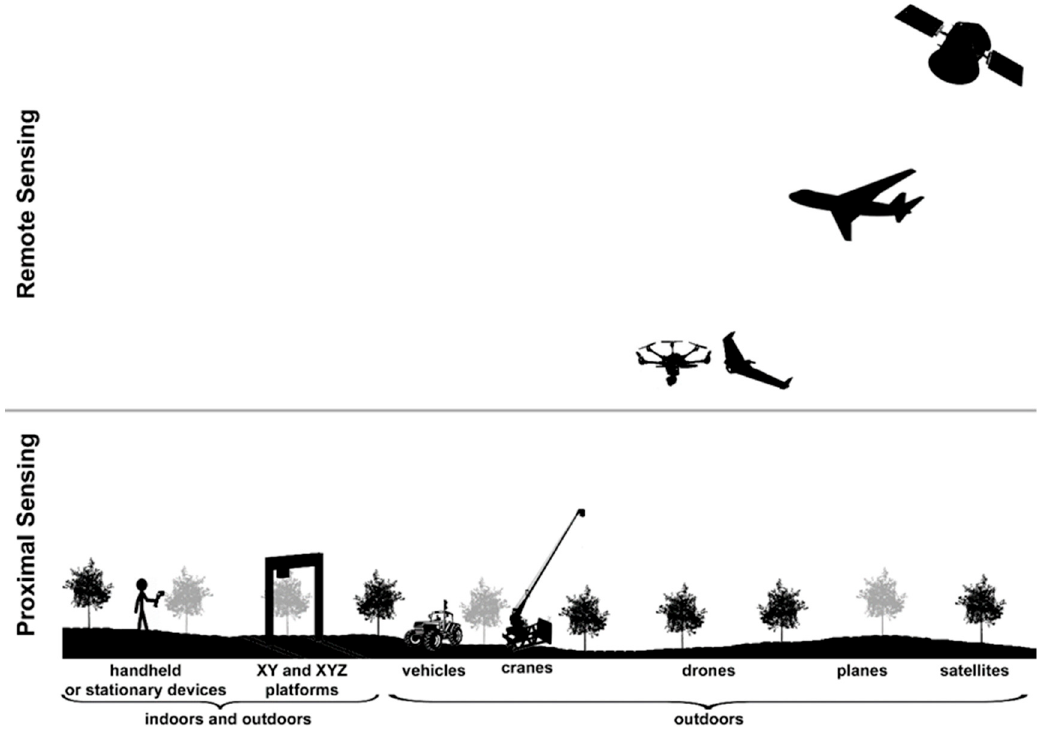
Figure 1. The most common platforms implementing thermal cameras at proximal and remote sensing scale.